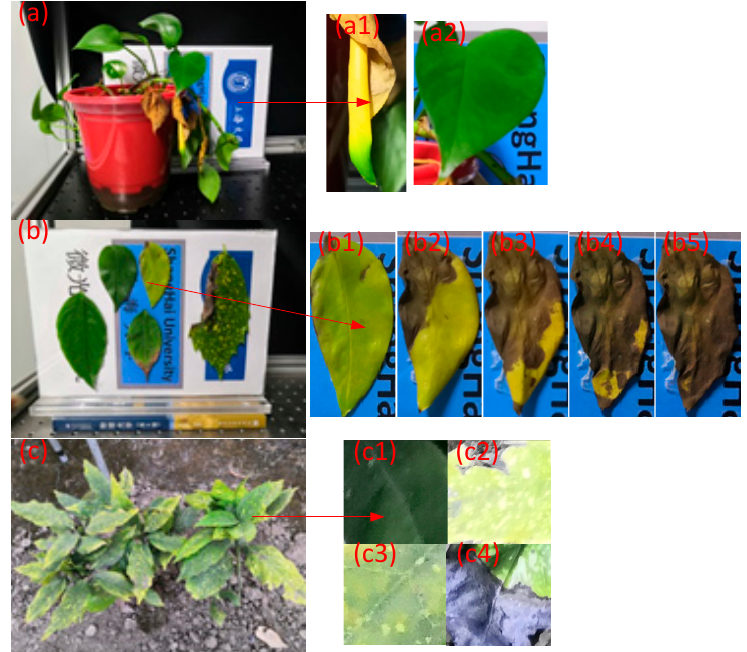
Figure 1. Plant materials. ( a ) Money plant: ( a1 , a2 ) are the regions of interest for the NDVI and polarization data collection, respectively. ( b ) The leaves of a spotted laurel, money plant and Malabar chestnut: ( b1 – b5 ) are the images of the changes of a money plant leaf every 3 days. ( c ) A spotted laurel at Shanghai University: ( c1 – c4 ) are the healthy leaf region, the level-2 stress leaf region, the level-1 stress leaf region and the withered leaf region, respectively.